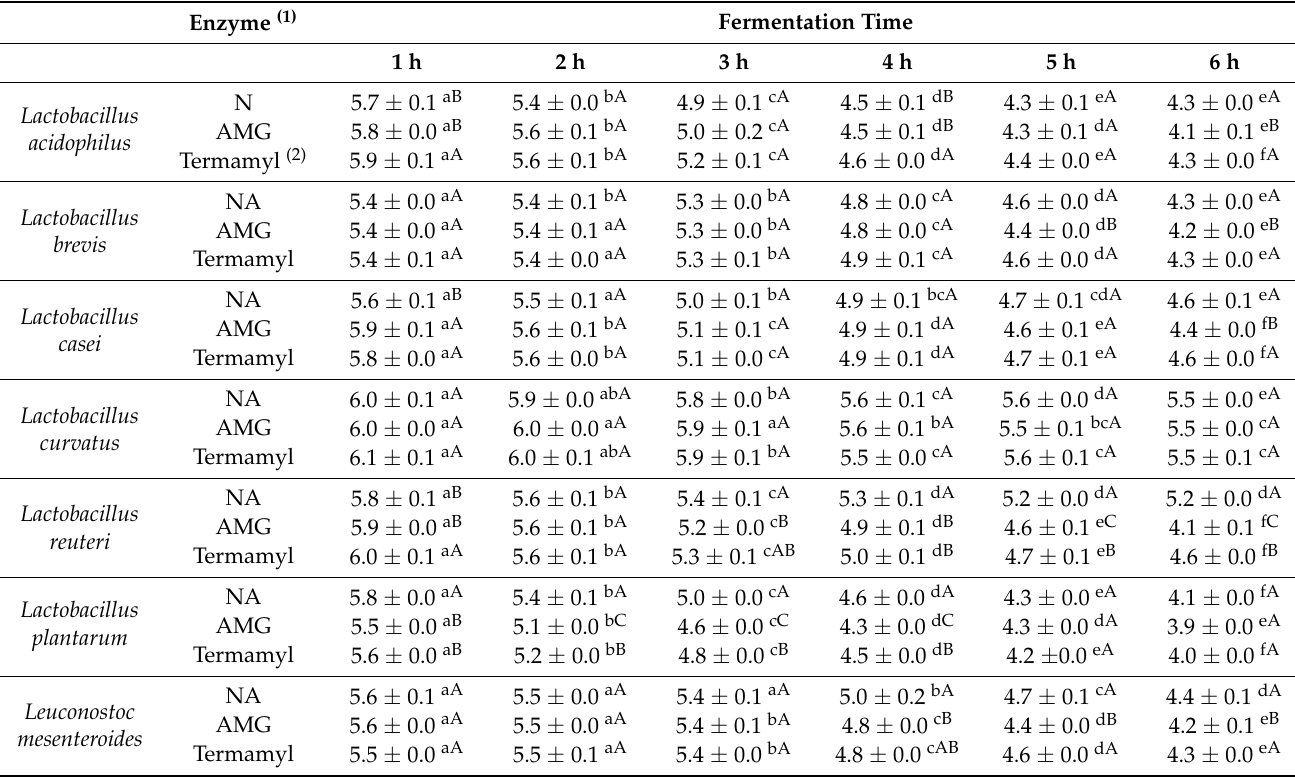
Table 1. Changes in the pH of fermented rice water according to the lactic acid bacteria and enzymes used in the